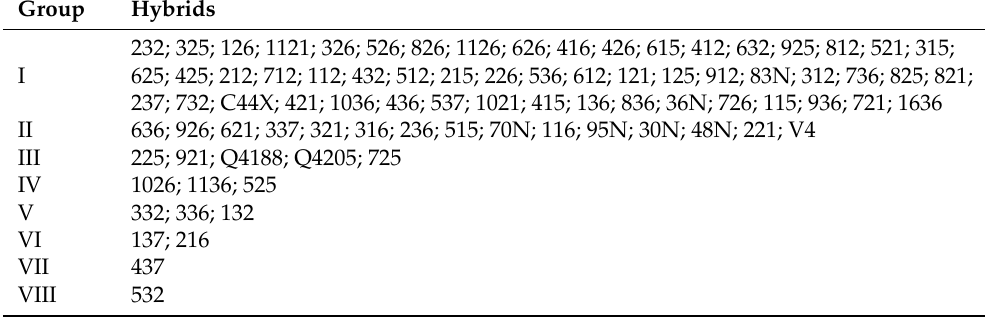
Table 4. Composition of groups formed by the Tocher optimization method for evaluated intraspecific hybrids of P. notatum Flügge, based on the average genetic Euclidean distance matrix. Group